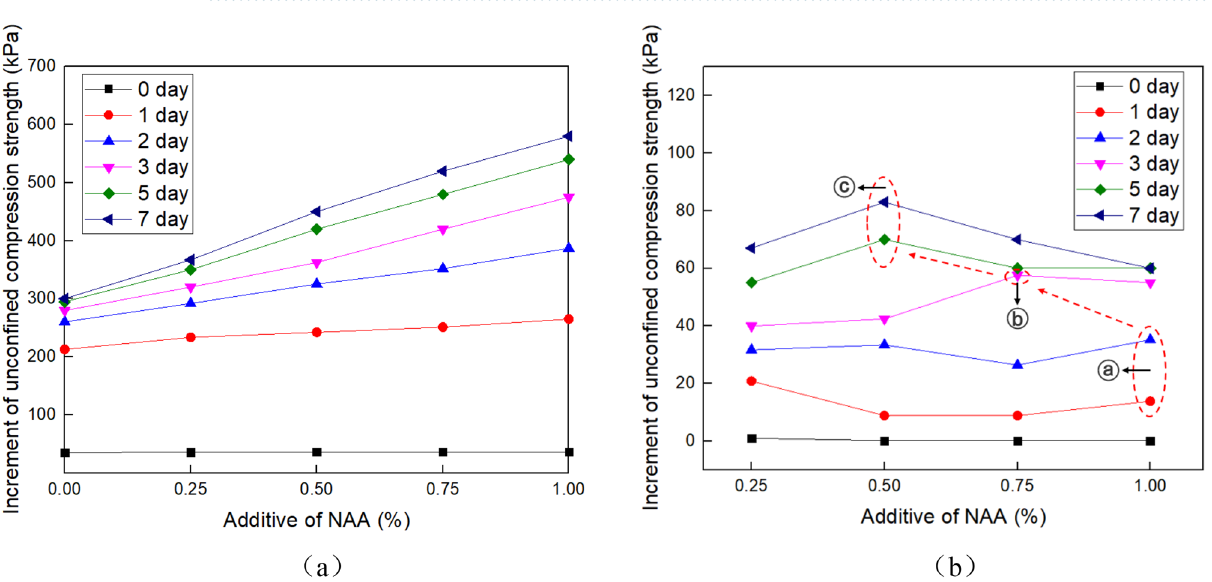
Figure 4. Unconfined compressive strength of the soil under different NAA content. ( a )The strength of the soil, and ( b ) The strength increment of the